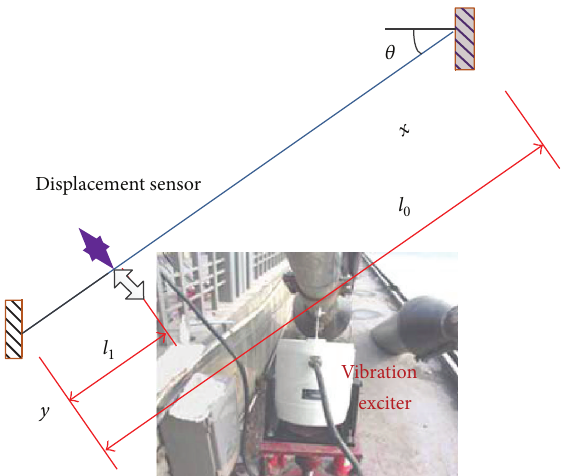
Figure 10: Excitation test of a full-scale